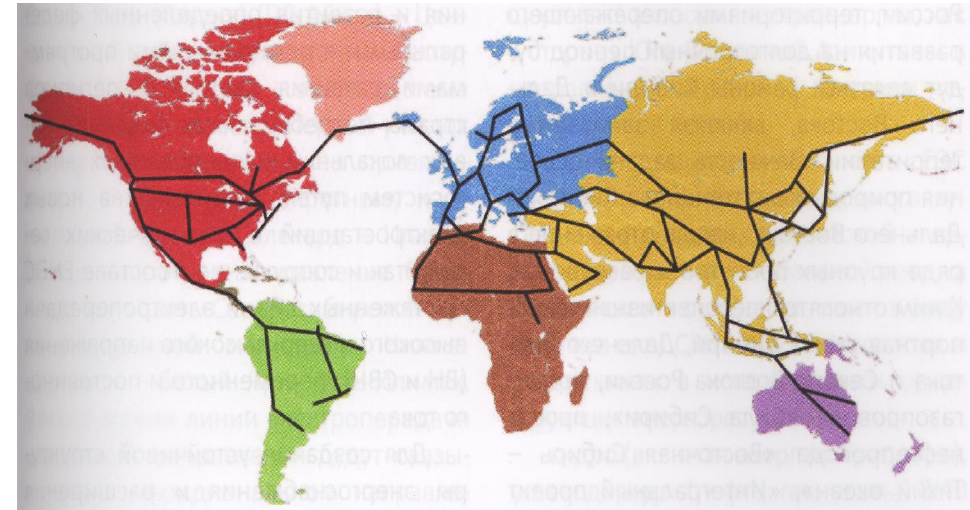
Figure 3. Possible scenario of Global Energy Interconnection development [17].